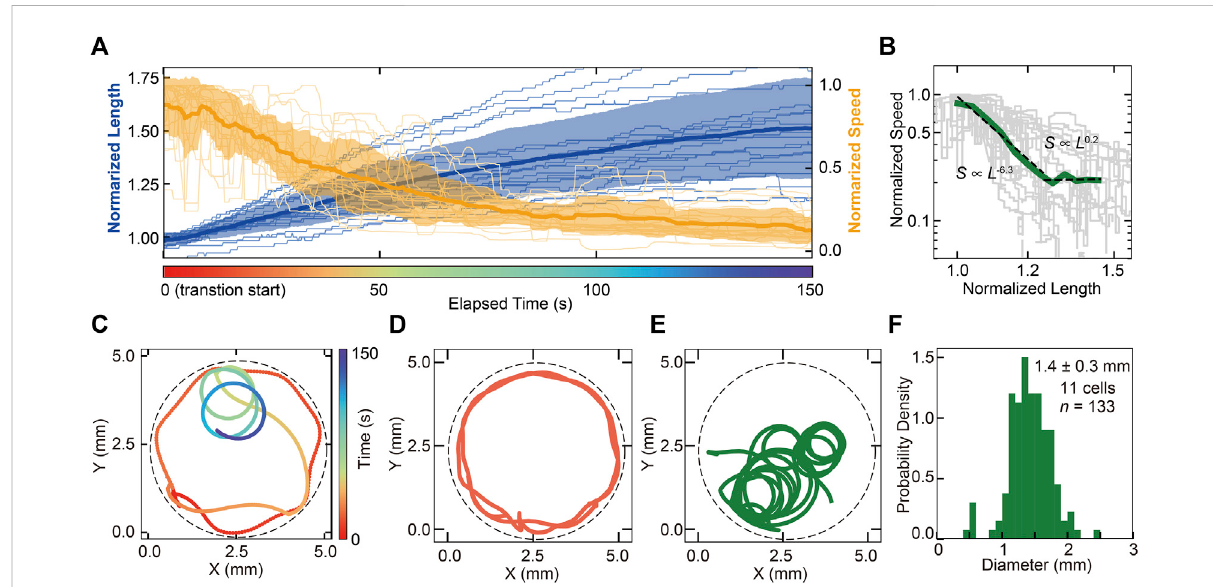
FIGURE 3 The processes of behavioral switching from swimming (coneshaped)to adhering (trumpet shaped). (A) Time series of the cell length (blue line) and swimming speed (orange line) of the cell in the transition from cone to trumpet (Figures 2E,F). Averaged lines are represented as solid bold lines, and individual data are represented as solid thin lines. Standard deviations of values for each cell at a time point are the transparent regions. These valuesarenormalizedbyCone=1.Itshowsthenegativecorrelationbetweenthecelllengthandswimming speed. (B) Thecorrelationbetween cell length and speed. The green solid line represents the average speed. Gray lines are individual transition data, and averaged data are fi tted by power laws. The characteristic factors of the law are − 6.3 in the range of 1 – 1.25 (normalized length) and 0.2 in the range of 1.25 – 1.45 (normalized length). (C) The trajectory of a cell in the behavioral transition from swimming to adhering. As the cell elongates, the cell becomes locally rotating. The color represents elapsed time from the beginning of the transition. The dashed line represents the wall of the chamber. (D,E) The comparison between the swimming trajectories at swimming steady state and steady rotating state. (F) The distribution of the swimming pass diameter in the steady rotating state. The diameter was 1.4 ± 0.3 mm (SD, n = 133, 11